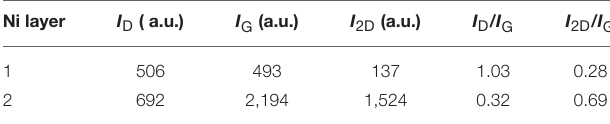
TABLE 4 | Intensities and intensity ratios of D, G, and 2D peaks for films deposited on single- and bilayer Ni catalysts using laser energy of 3 mJ ( Dong et al., 2017). Ni